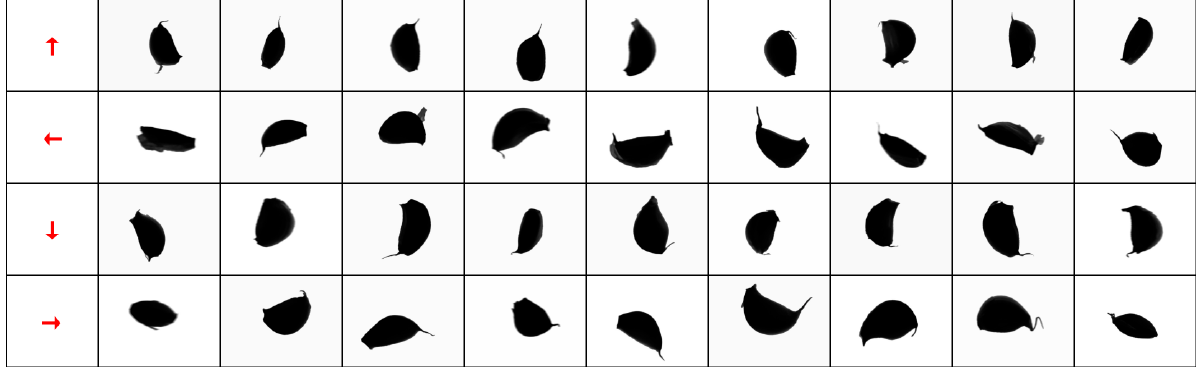
Figure 7. Image samples after rotation in the range of ± 30°.